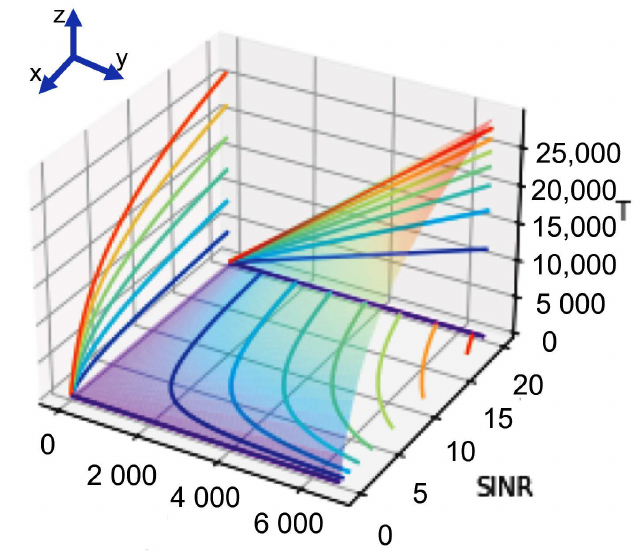
Figure 5. Throughput.